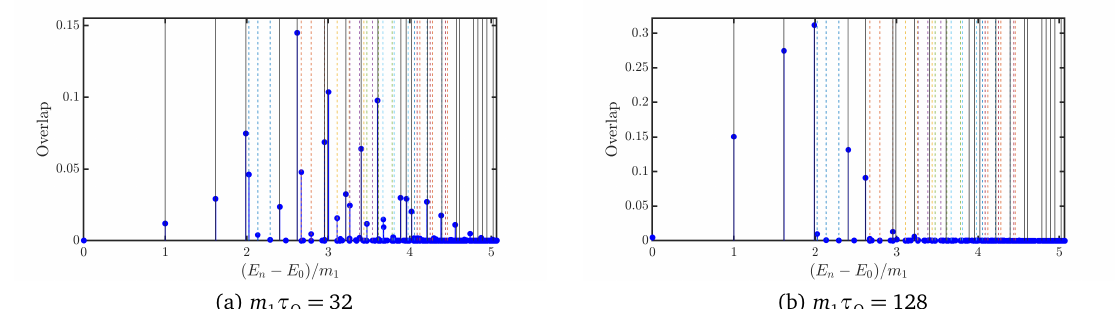
/ 2 ) along the E direction Q 8